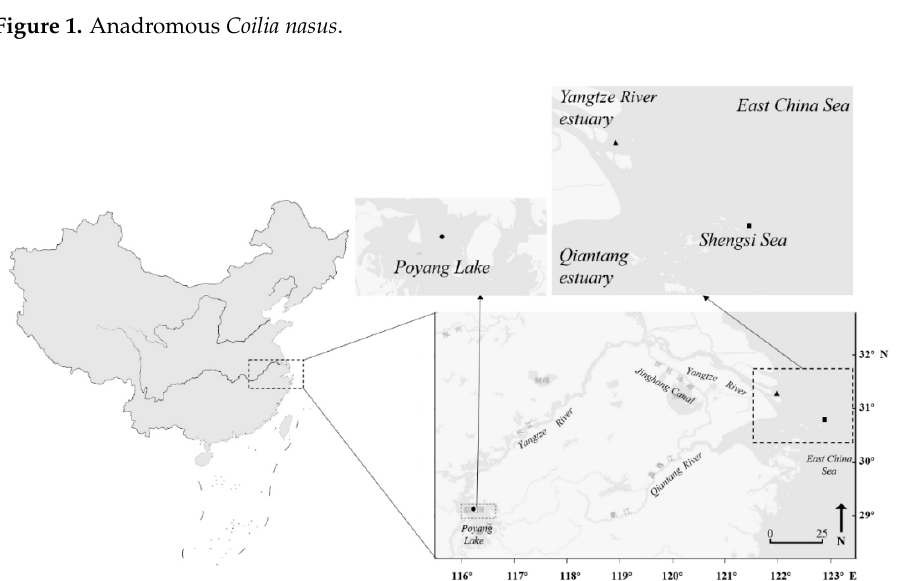
Figure 2. Map showing the Coilia nasus sampling sites: Shengsi Sea area (S group) around 30°81 ′ N 122°90 ′ E, Yangtze River estuary (E group) around 31°27 ′ N 121°95 ′ E and Poyang Lake (P group) around 29°15 ′ N 116°27 ′ E).